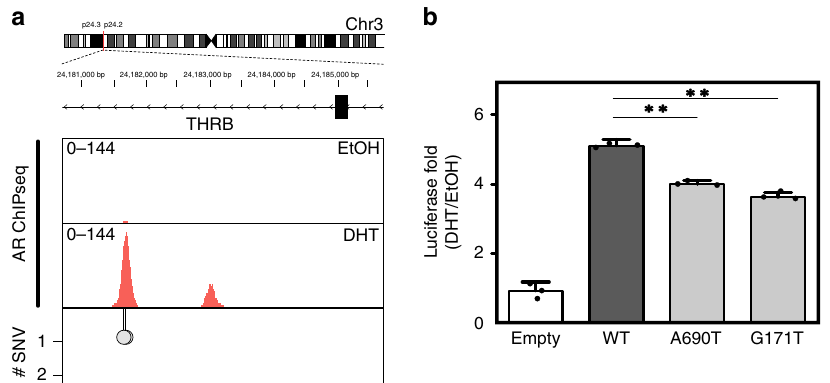
Fig. 5 SNVs at ARBS can impact enhancer activity. a SNVs were found from two separate patients at an ARBS in the intronic region of thyroid hormone receptor beta (THRB). b Clinical SNVs mutations (dark gray) signi fi cantly impaired luciferase activity as compared with the wild-type enhancer (light gray) ( n = 3, mean ± SD, ** p < 0.001).